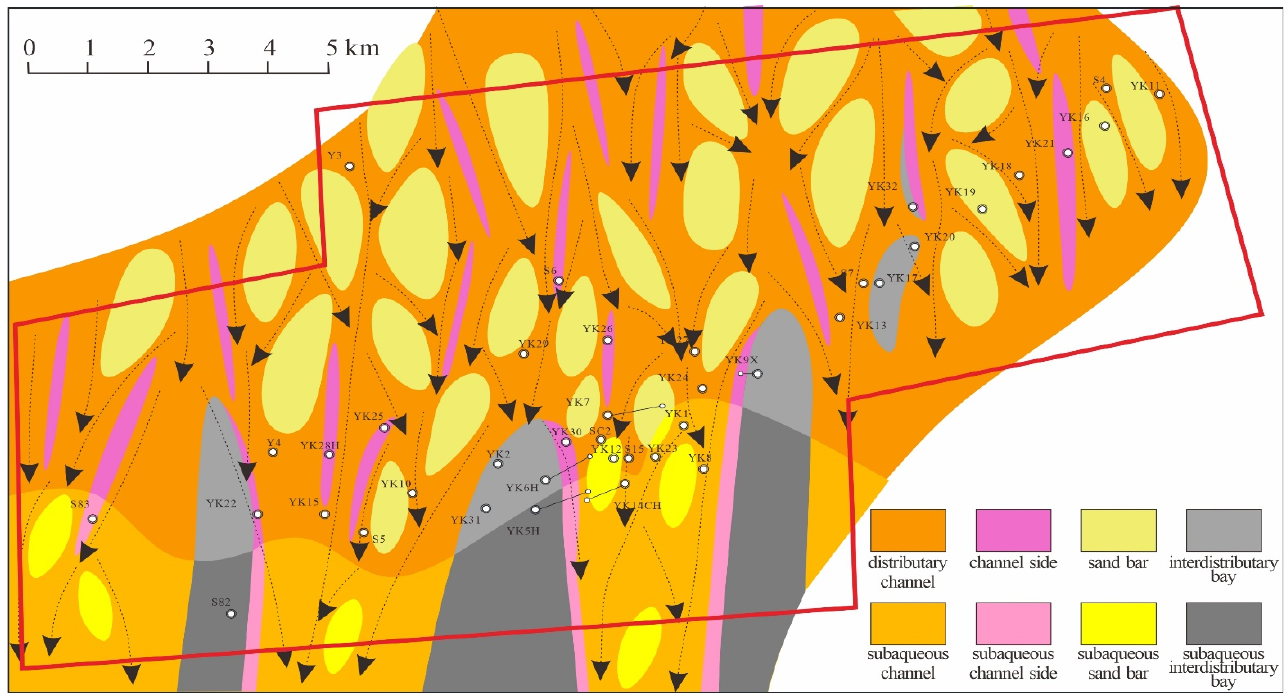
Figure 12. The facies map of a typical layer.